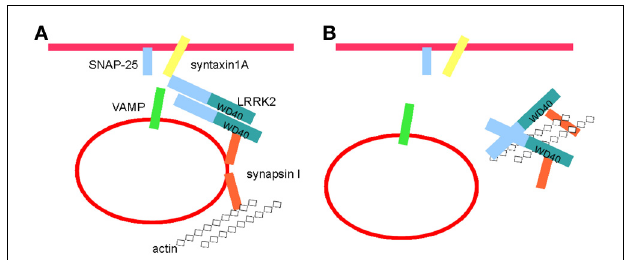
FIGURE 8 | Kinase activity controls LRRK2 molecular complex at the synaptic site. (A) LRRK2 binds SV and regulates thier trafficking via interaction with a panel of presynaptic proteins, including synapsin I, syntaxin 1, SNAP-25, VAMP, and actin (see also Piccoli et al., 2011, 2014). (B) Kinase inhibition detaches LRRK2 from SV and might induce the formation of high-molecular weight complex including LRRK2, synapsin I and actin. Such complex might sequester LRRK2, synapsin I and actin thus hampering their function within SV